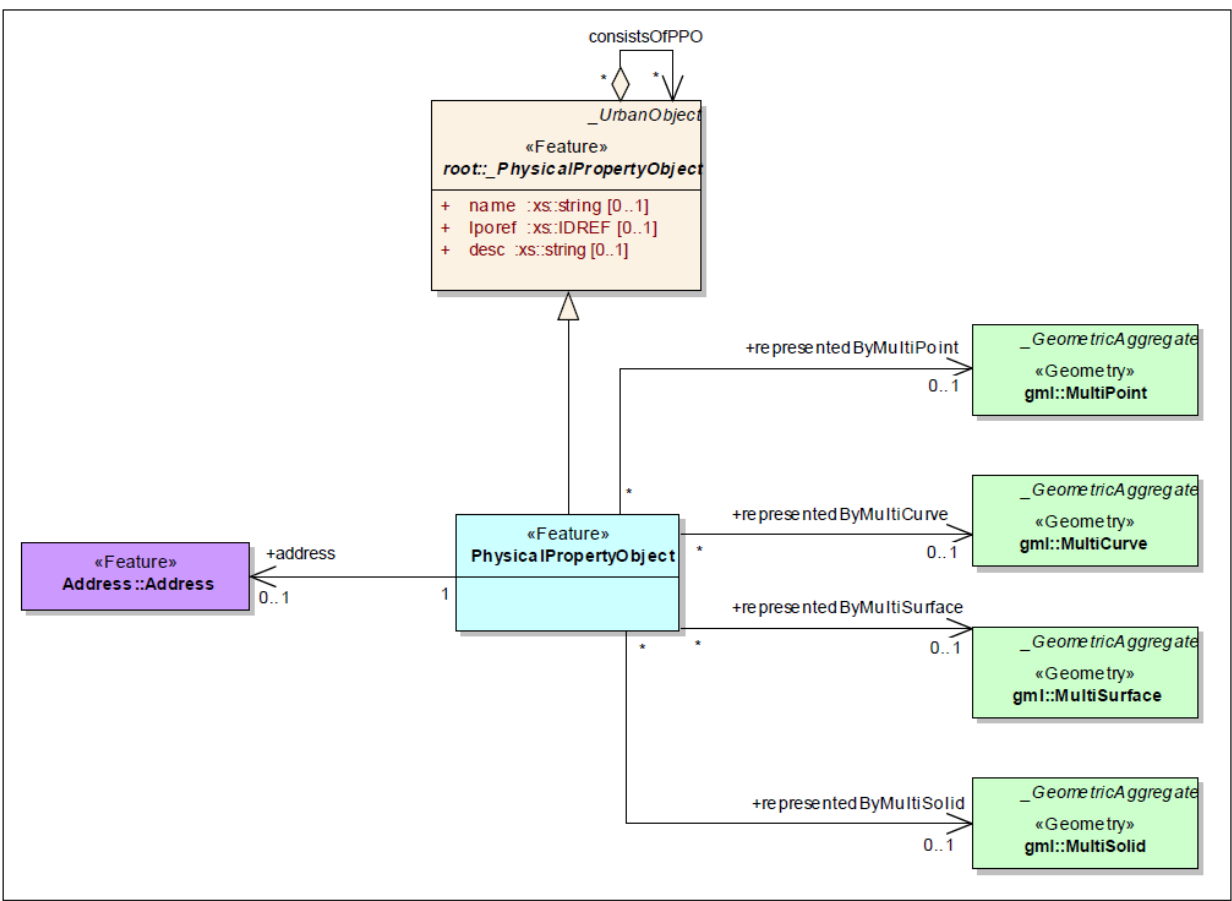
Figure 22. The UML diagram of 3DCDM PhysicalPropertyObject